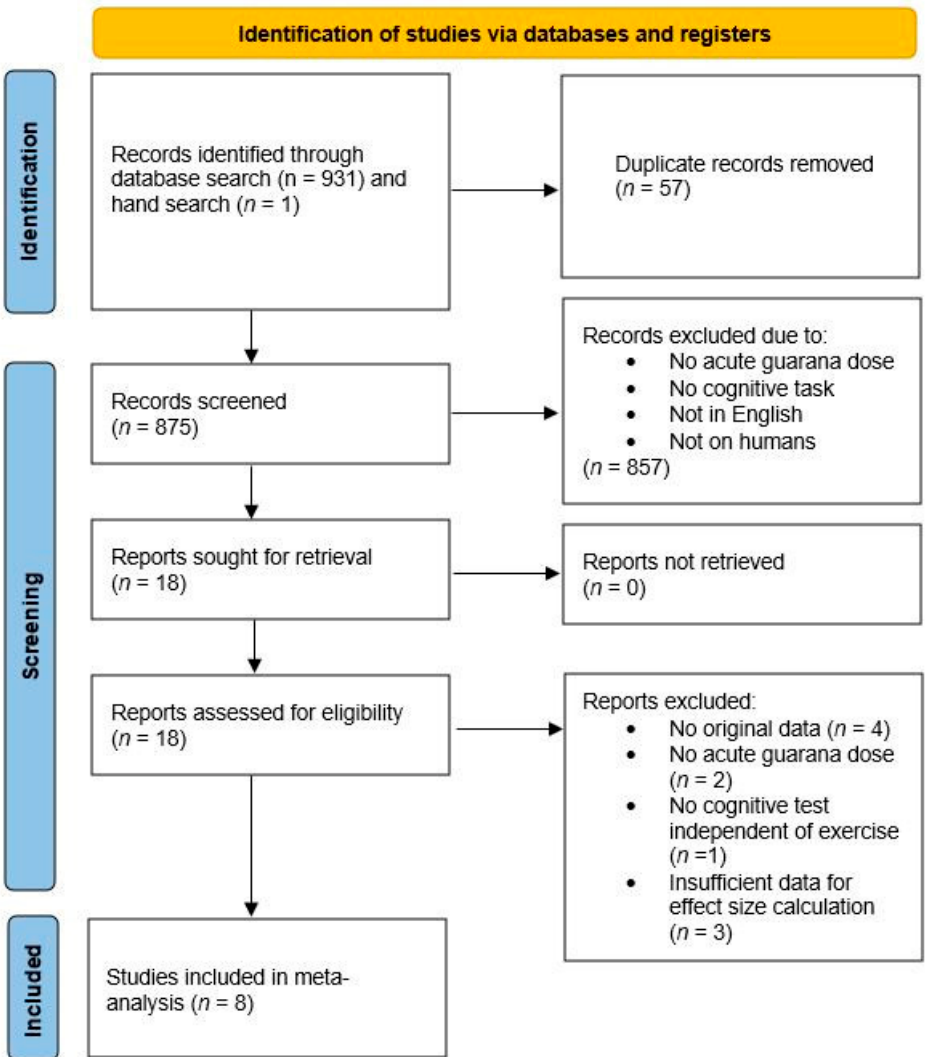
Figure 1. PRISMA flowchart detailing study identification.